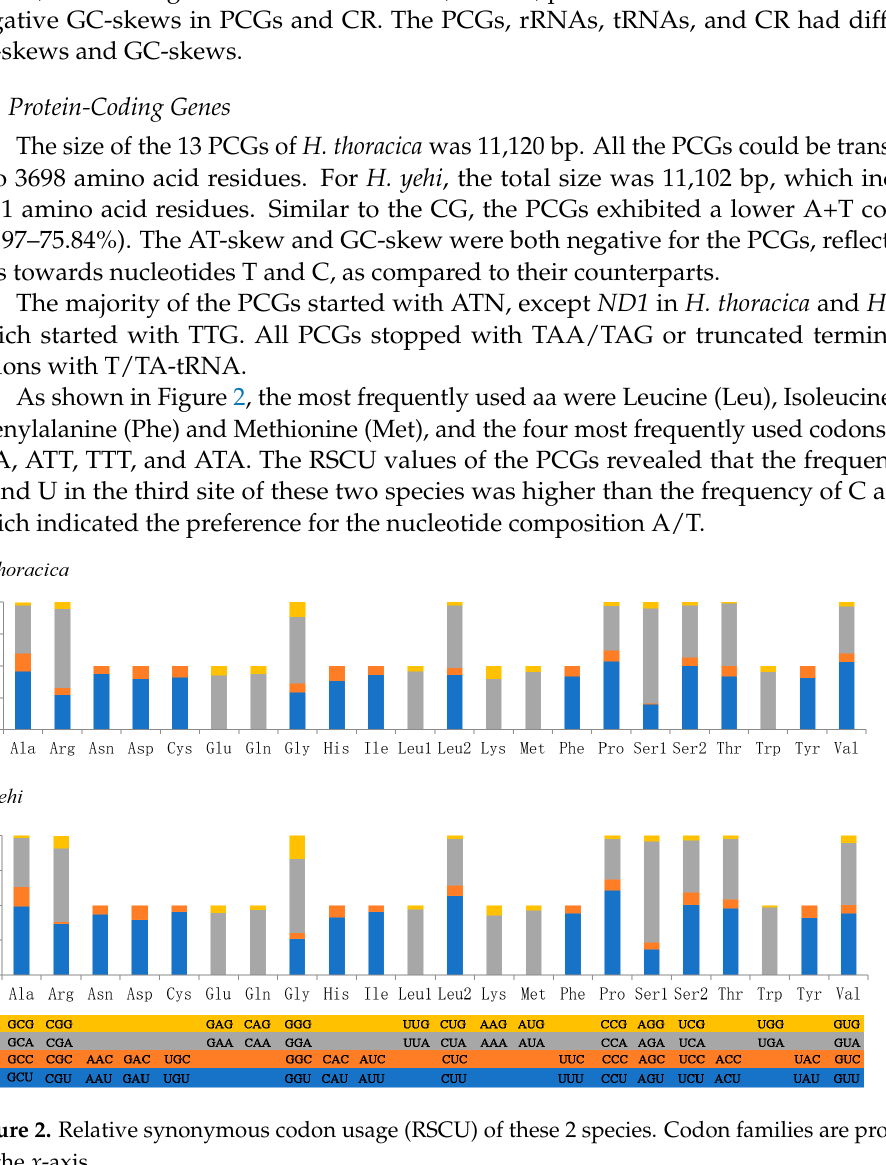
Figure 2. Relative synonymous codon usage (RSCU) of these 2 species. Codon families are provided on the x on the x -axis.